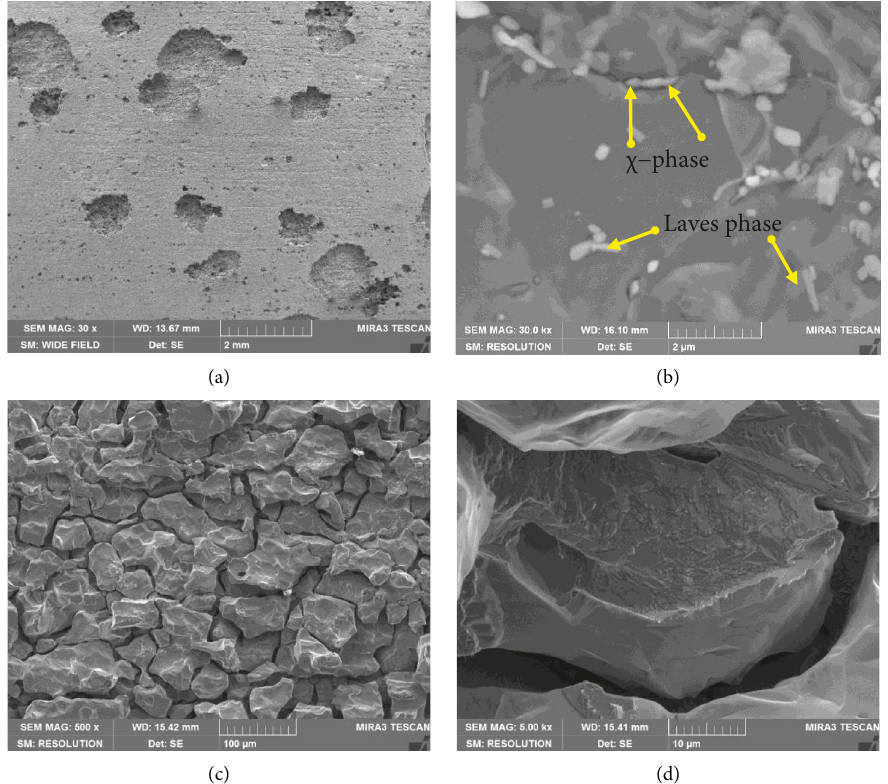
Figure 6: The surface morphologies of representative samples after immersion corrosion: (a), (b) immersion for 24h of samples soaking for 4h at 600 ° C, (c, d) immersion for 24h of samples soaking for 4h at 800 ° C.